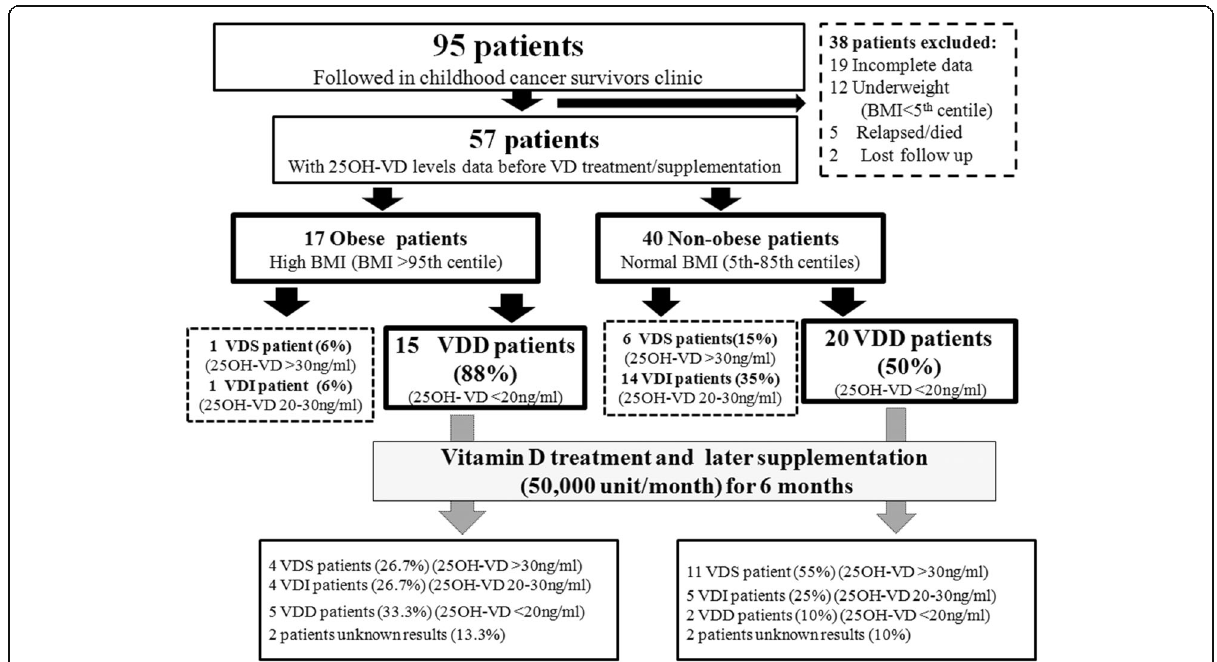
Fig. 1 Flow chart of studied patients. 25OH-VD, 25-hydroxy vitamin D; BMI, body mass index; VDD, vitamin D deficient; VDI, vitamin D insufficient; VDS, vitamin D